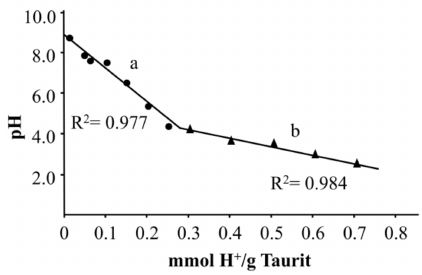
Figure 3. Acid neutralization capacity of Taurit (a) until pH 4.0 and (b) from pH 4.0.